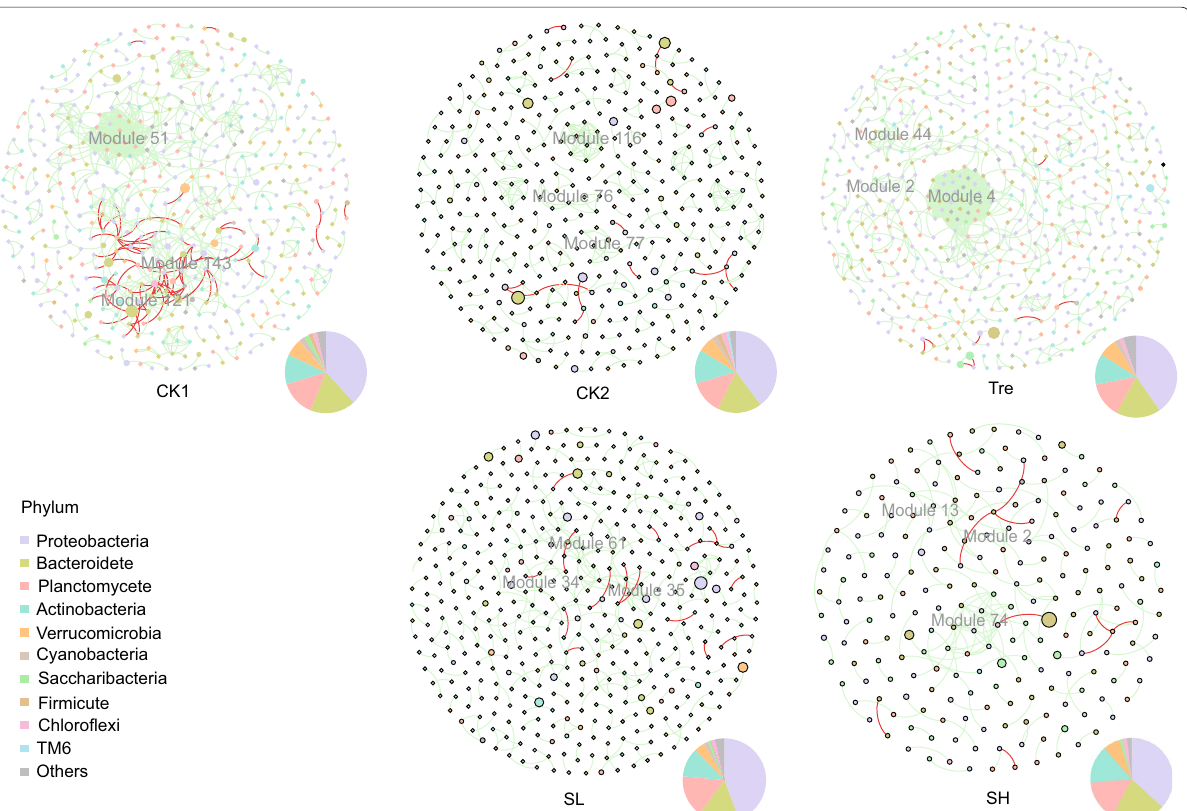
Fig. 6 Co-occurrence patterns of gut microbiota for subgroup. There are 156, 159, 152, 149 and 82 modules in CK1, CK2, Tre, SL and SH, respectively. The top 3 modules with more OTUs are marked in each network. The size of each node is proportional to the number of relative abundances. The nodes are colored according to